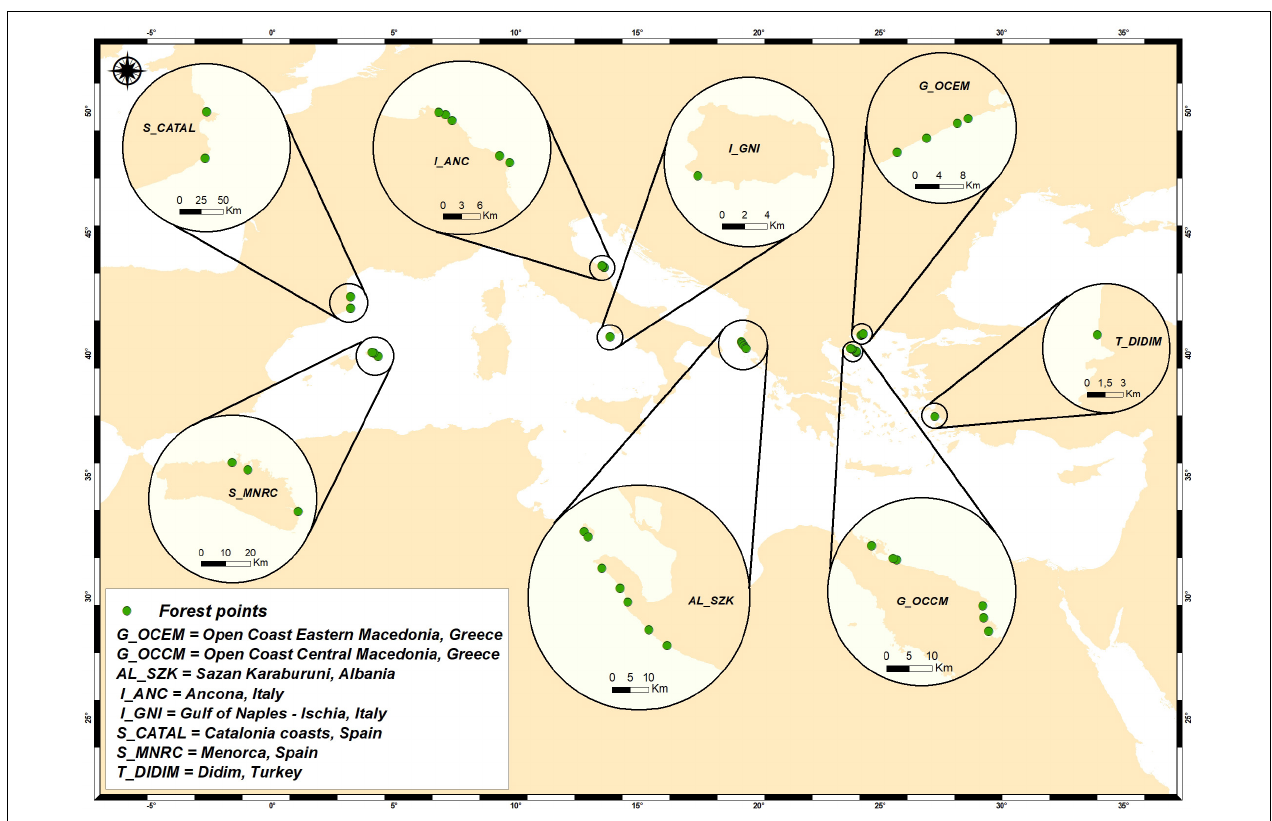
FIGURE 1 | A map of the sampled fucalean seaweed forests in the Mediterranean